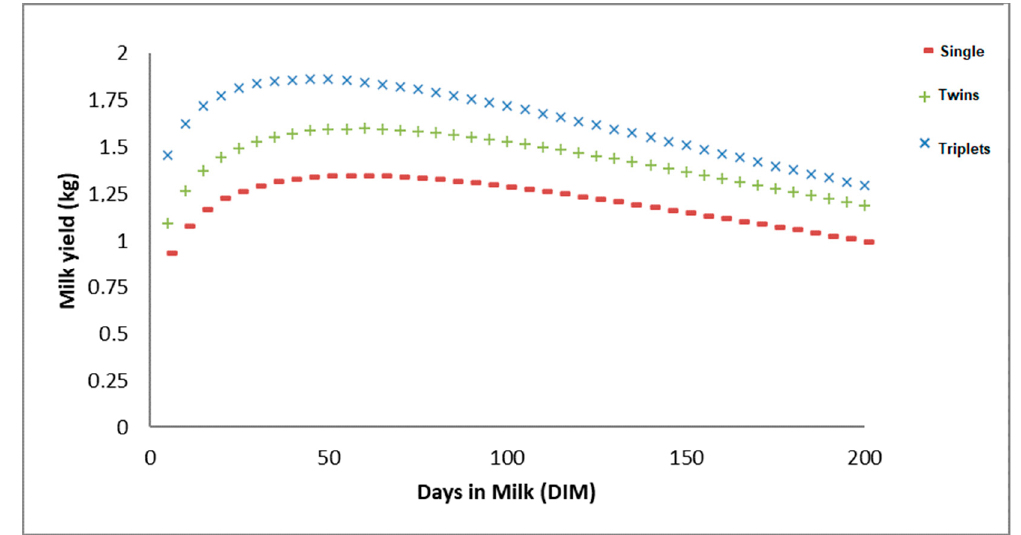
Figure 3. Linearized Wood’s function lactation curves across the number of kids levels.